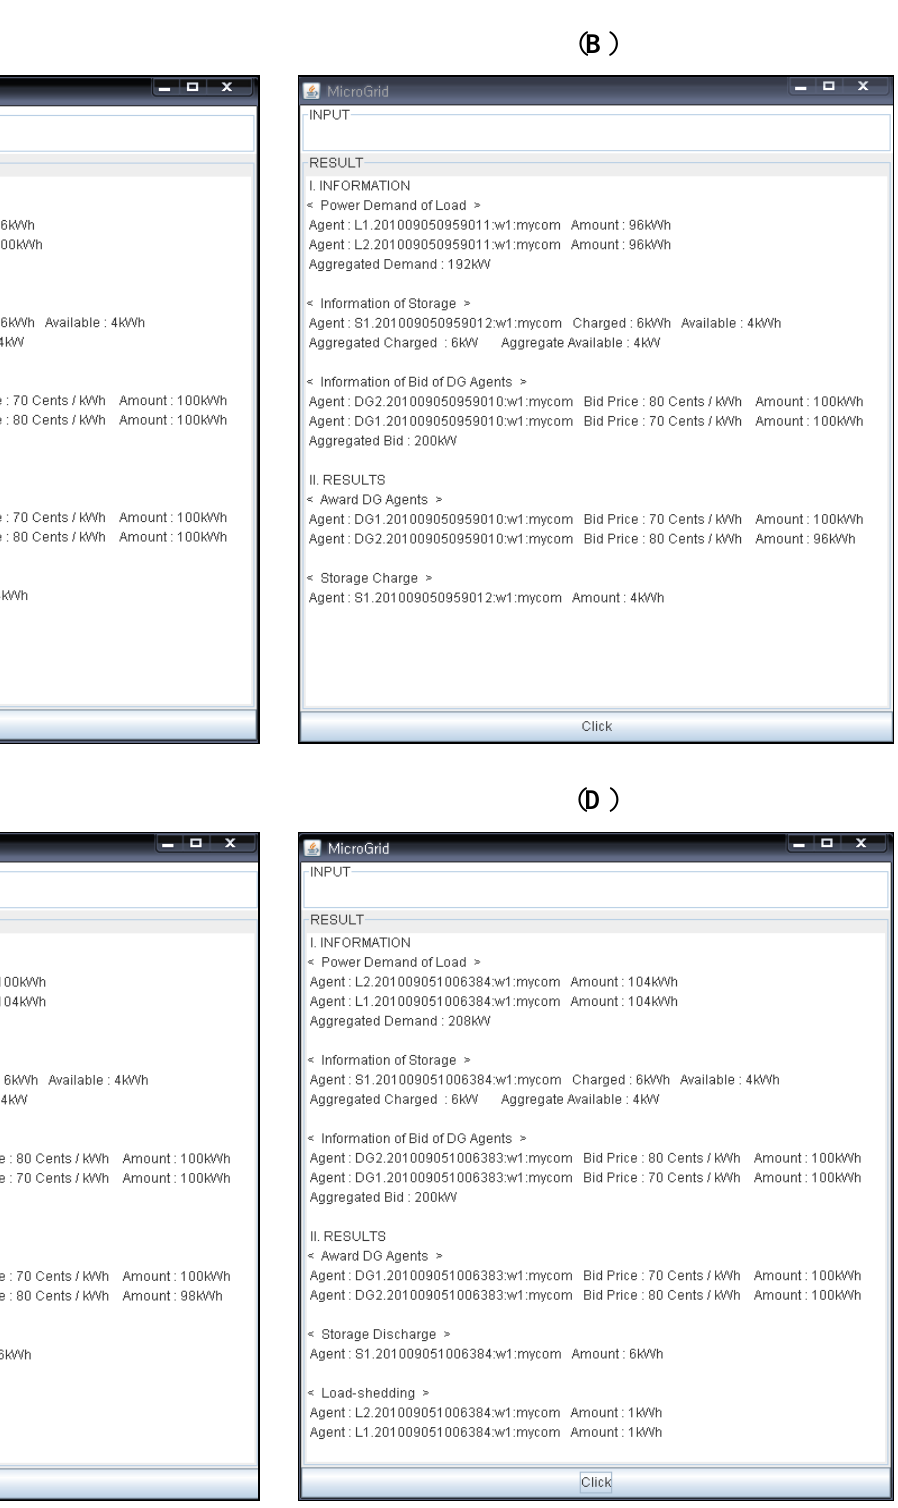
Figure 10. Result of ( A ) Case 1; ( B ) Case 2; ( C ) Case 3; ( D ) Case